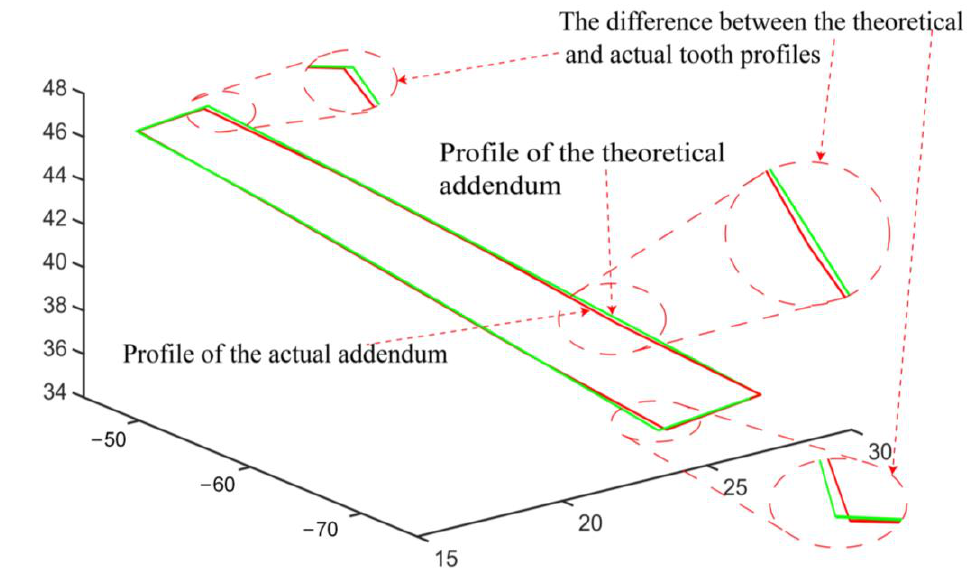
Figure 15. Top surface profile deviation for one gear tooth.